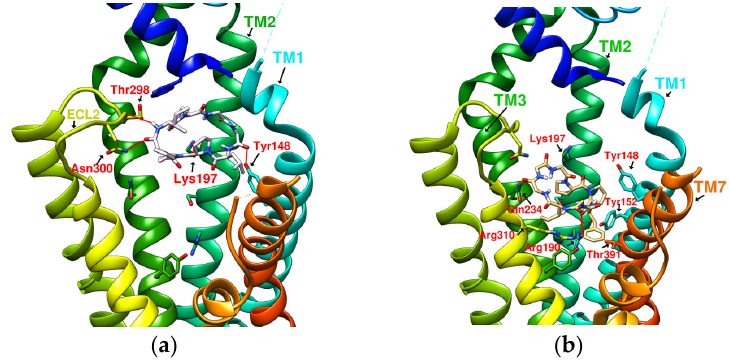
Figure 6. ( a ) HB/GLP-1R (−9.5 kcal/mol), ( b ) PB/GLP-1R (−10.4 kcal/mol).